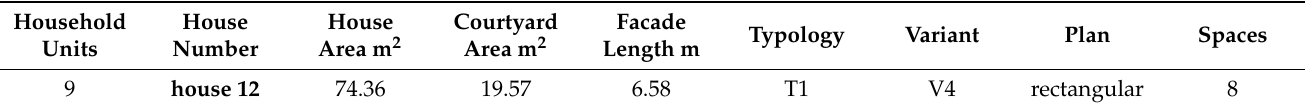
Figure 20. Variant 4. House 12. Plan and room distribution.